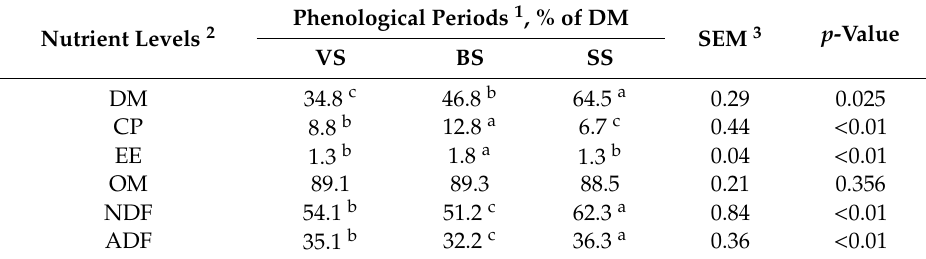
Table 2. Nutrient composition of herbage in di ff erent phenological